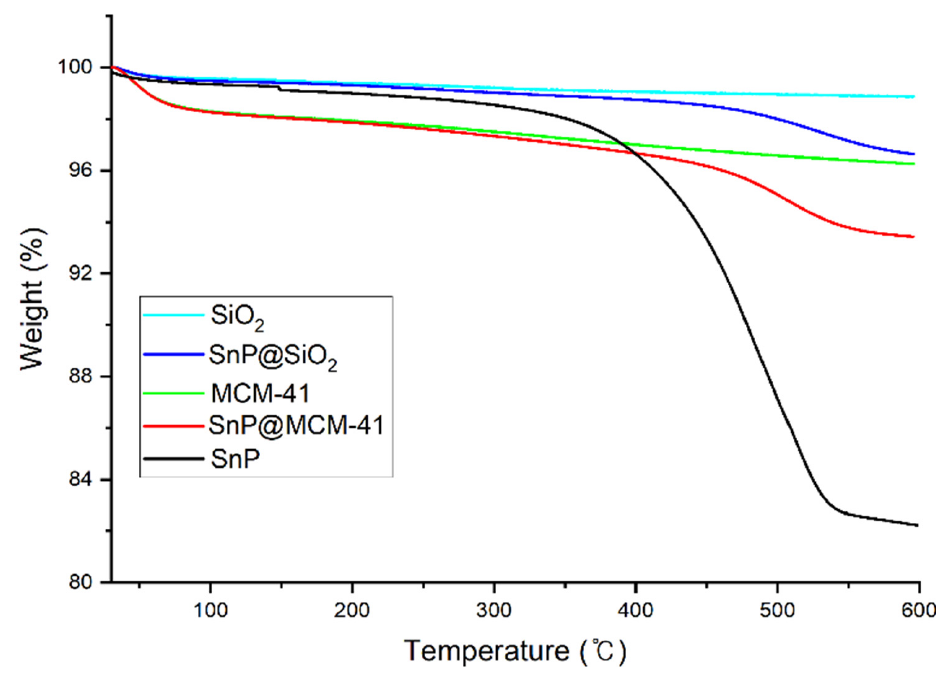
Figure 4. TGA curves of SnP , SiO 2 , MCM − 41, SnP@MCM − 41 , and SnP@SiO 2 .